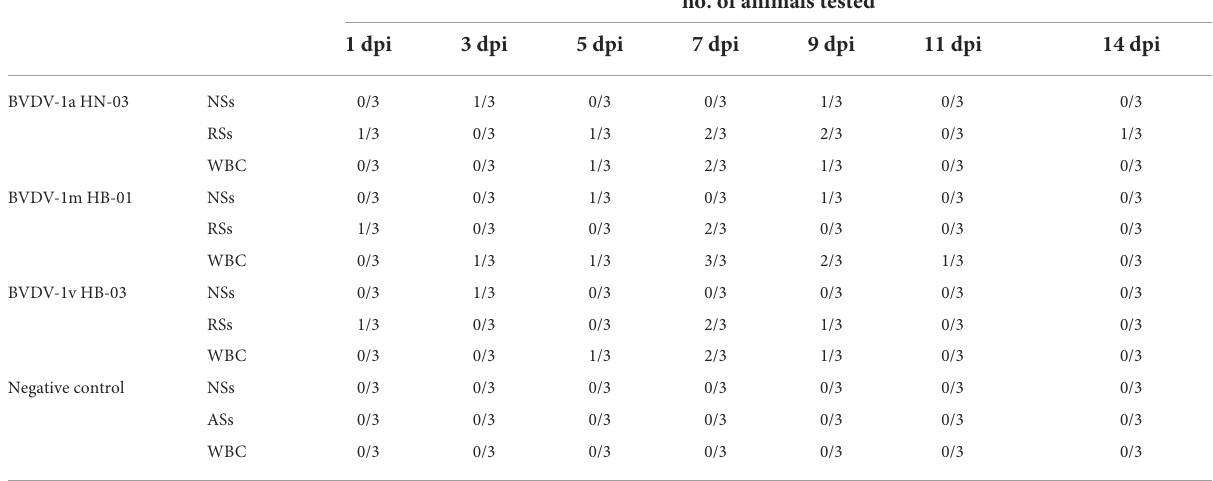
TABLE 2 Viral isolation from nasal swabs (NSs), rectal swabs (RSs), and white blood cells (WBC) at different time points. BVDV